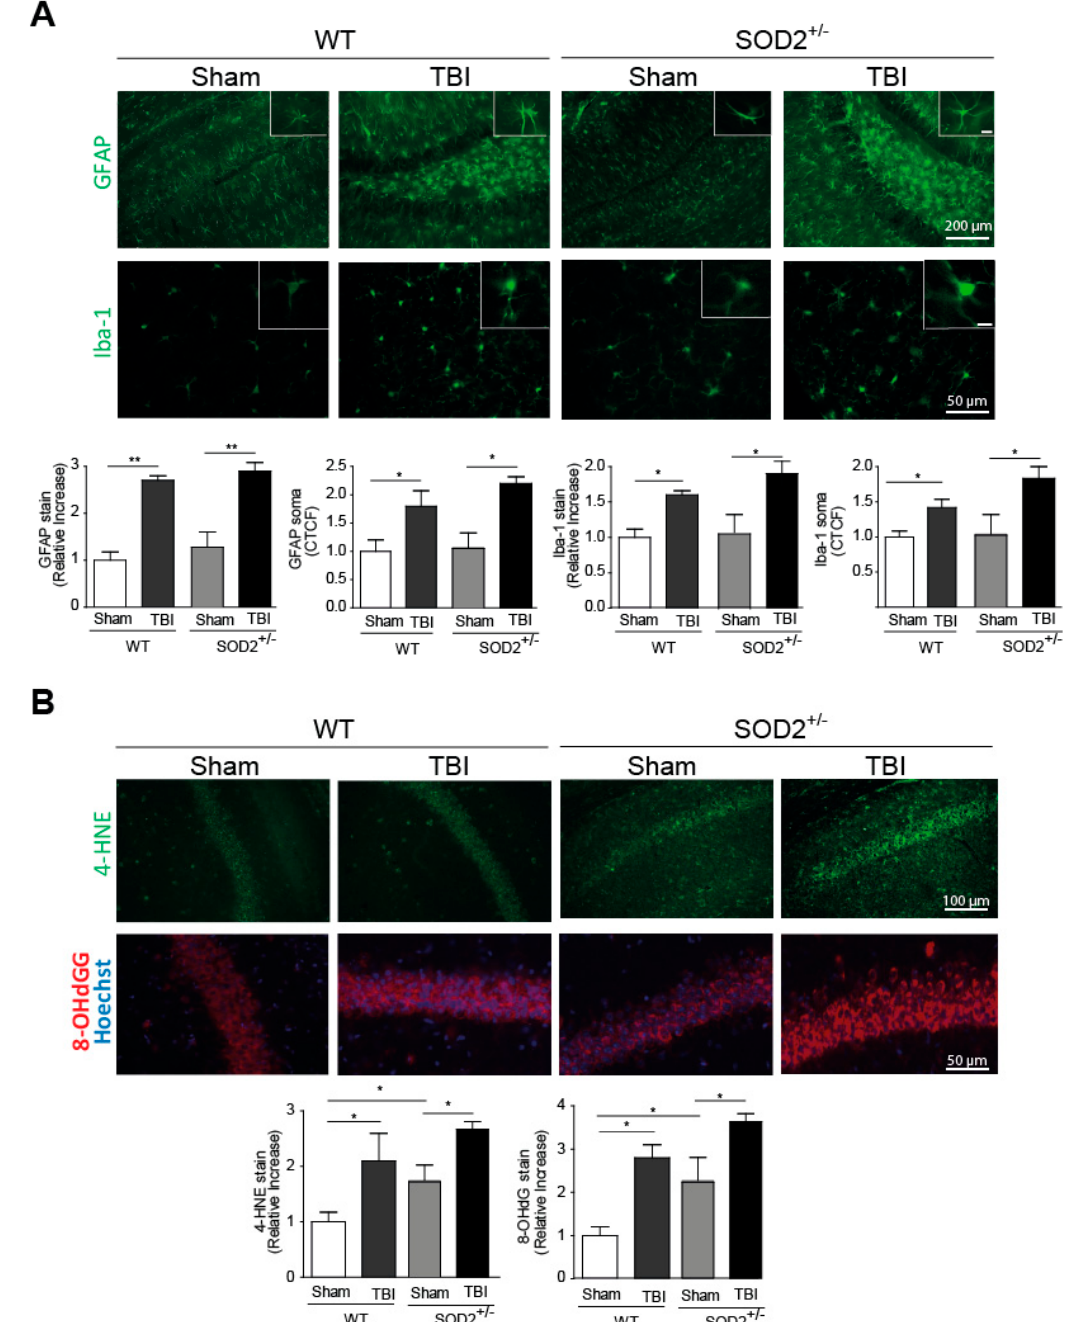
Figure 1. Neuroinflammation and oxidative stress are increased in hippocampal slices from mice after TBI. ( A ). Repre- sentative immunofluorescence images showing GFAP and Iba-1 in hippocampal slices from mice 1 week after TBI. The graphs show the quantification of fluorescence intensity in the selected area of hippocampi and CTCF of soma from GFAP and Iba-1 reactive cells. Inset scale bar correspond to 10 µ m. ( B ). Representative immunofluorescence images showing 4-HNE and 8-OHdG in hippocampal slices from mice 1 week after TBI, specifically in the CA1 region. The graphs show the quantification of fluorescence intensity in the CA1 hippocampal region. 3 animals were used per experimental group and 9–12 images per animal were analyzed. CTCF was measured, using 10 cells per image, 5 images per animal. Data are means ± S.E and are relativized to the WT Sham group. Statistical differences were calculated by ANOVA, followed by post hoc Bonferroni’s test. Asterisks indicate the statistical significance of the observed differences (* p < 0.05; ** p < 0.01). (GFAP, Glial fibrillary acidic protein; TBI, Traumatic brain injury; Iba-1, Ionized calcium-binding adaptor molecule 1; 4- HNE, 4-Hydroxynonenal; 8-OHG: 8-hydroxy-2’-deoxyguanosine, CTCF: corrected total cell fluorescence).